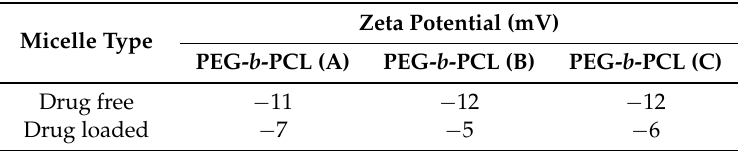
Table 6. The zeta potential of micelles formed by injecting 5 mL of the organic phase into 25 mL of water through the membrane. The organic phase for drug-free micelles was 1 mg ¨ mL ´ 1 of PEG- b -PCL in acetone. The organic phase for drug-loaded micelles was 1 mg ¨ mL ´ 1 of fluconazole per 1 mg ¨ mL ´ 1 of PEG- b -PCL in